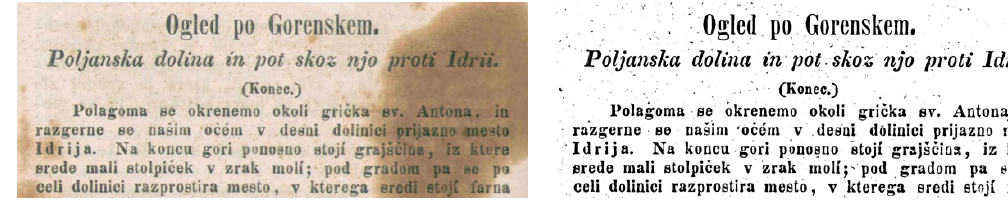
Figure 13. Example of adaptive thresholding applied on a degraded document image.